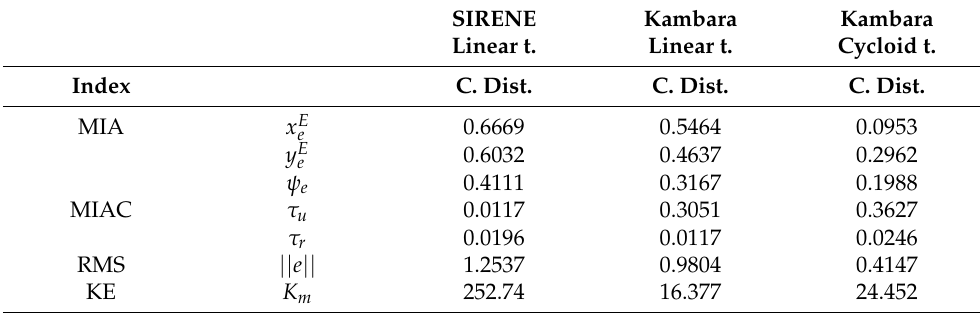
Table 4. Performance for SIRENE and Kambara.